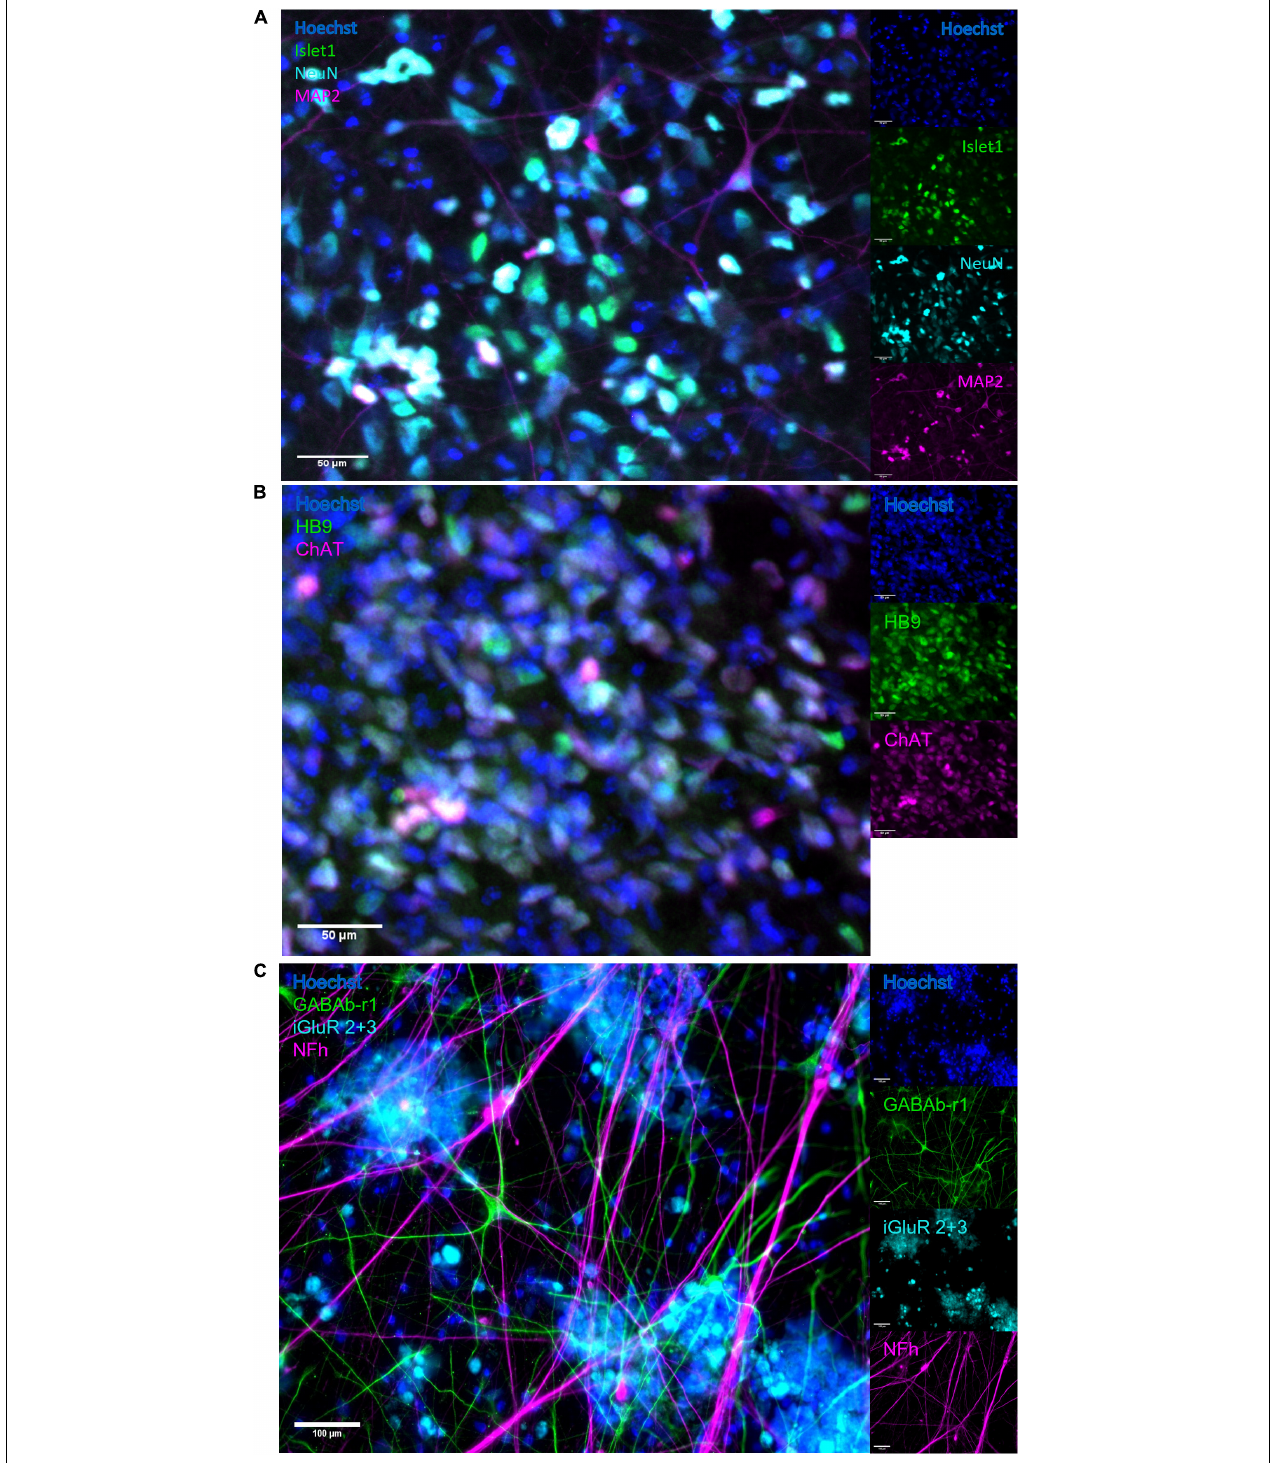
FIGURE 2 | Immunocytochemistry. After maturation, neurons expressed motor neuron specific markers as well as relevant neurotransmitter receptors and markers of mature cytoskeleton. (A) Overlap of expression of motor neuron specific marker Islet1 and neuronal marker NeuN, alongside heavy neurofilament, indicates the presence of mature motor neurons. Scale bar 50 µ m. (B) The co-expression of motor neuron markers HB9 and ChAT further confirms motor neuron identity. Scale bar 50 µ m. (C) Expression of receptors for GABA and glutamate confirms the capacity for excitatory signalling within the motor networks, as well as the susceptibility of the networks to the GABA-inhibition. Scale bar 100 µ